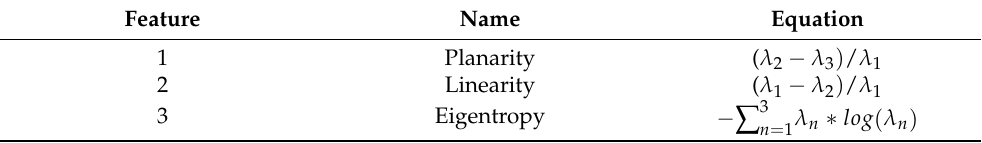
Table 1. Three geometric features extracted from the point clouds, λ represents